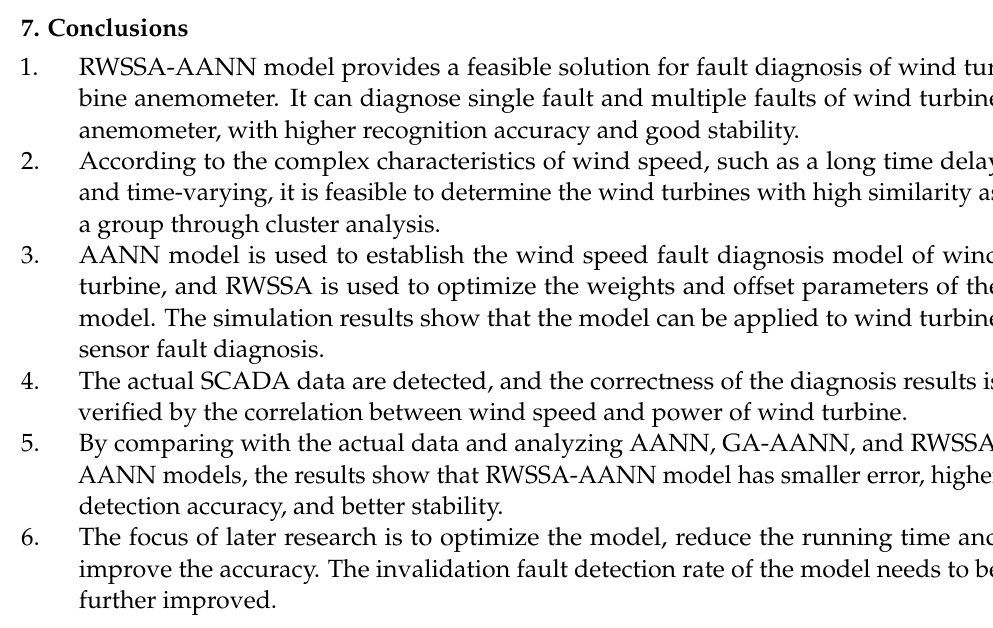
Table 5. Comparison of MSE and FDR values of three models.